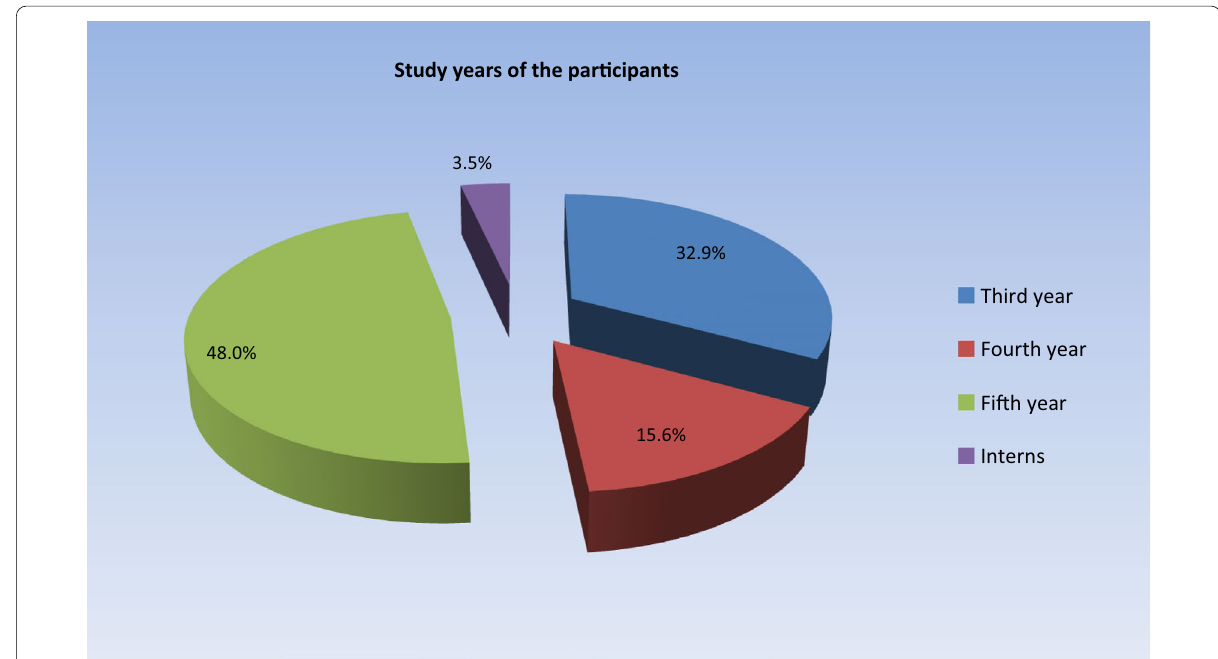
Fig. 2 Pie chart representing the distribution of study years among study